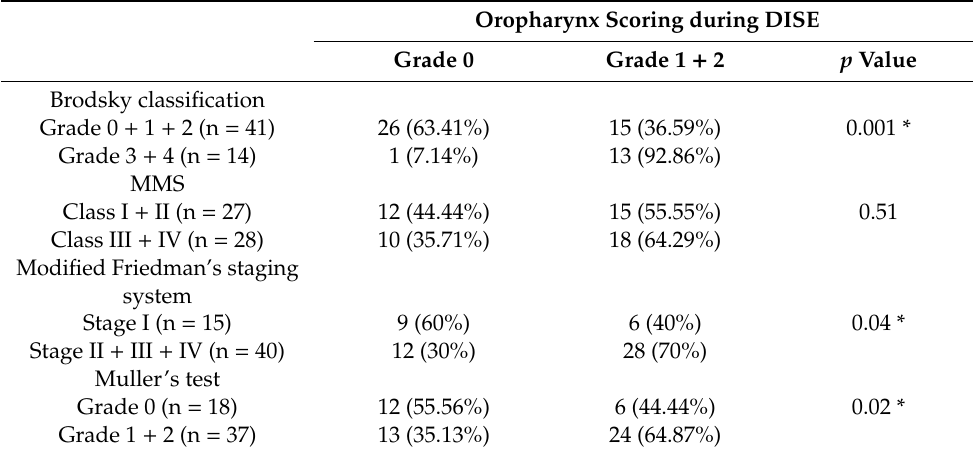
Table 4. Comparison of di ff erent levels of physical examinations and oropharynx collapse during